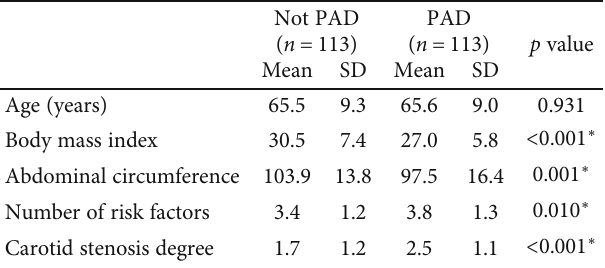
Table 2: Comparison between patients with and without PAD in relation to carotid stenosis, age, number of risk factors, abdominal circumference, and body mass index.